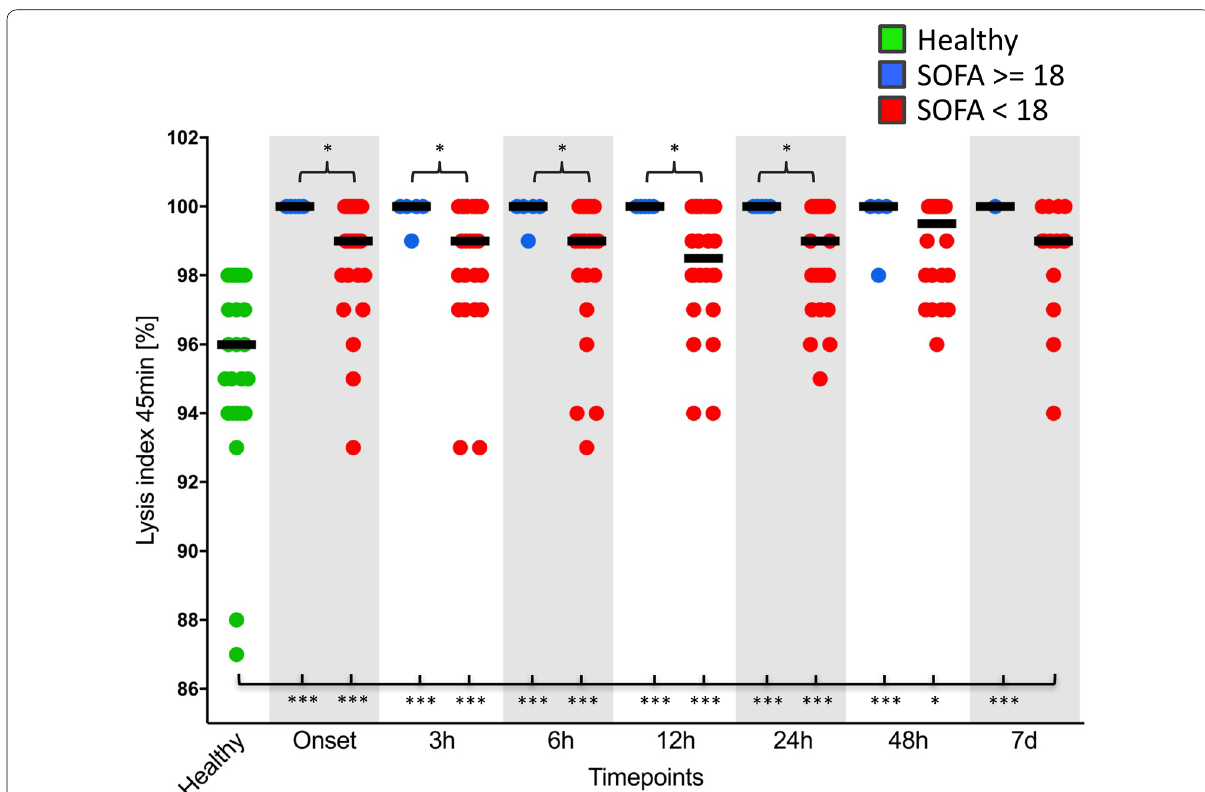
Fig. 5 EXTEM lysis index (LI) at 45 min in blood samples of healthy volunteers ( n 30; green dots), patients with septic shock and a sepsis‑related = organ failure assessment (SOFA) score 18 ( n 5 at onset; blue dots) and patients with septic shock and a SOFA score < 18 ( n 25 at sepsis onset; ≥ = = red dots). Blood samples from healthy volunteers were collected once, whereas samples from patients with septic shock were collected at sepsis onset as well as 3 h, 6 h, 12 h, 24 h, 48 h and 7 d later. A P value < 0.05 was considered statistically